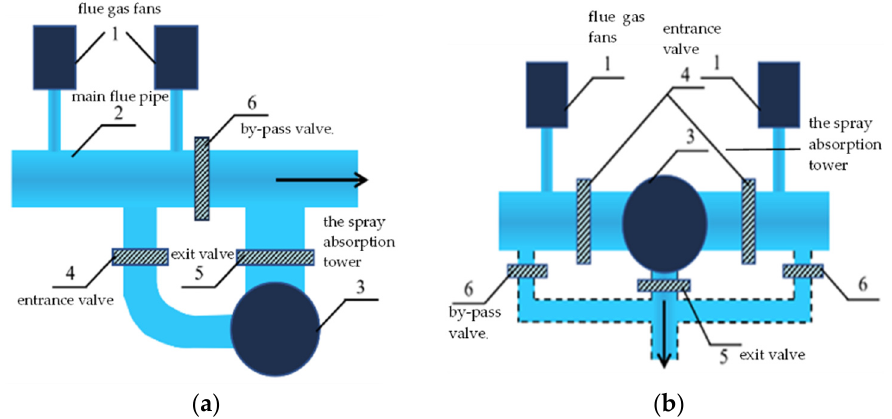
Figure 2. The layout of flue gas desulfurization tower; ( a ) Single inlet; ( b ) Dual inlet. 1—flue gas fans; 2—main flue pipe; 3—the spray absorption tower; 4—entrance valve; 5—exit valve; 6—by-pass valve.